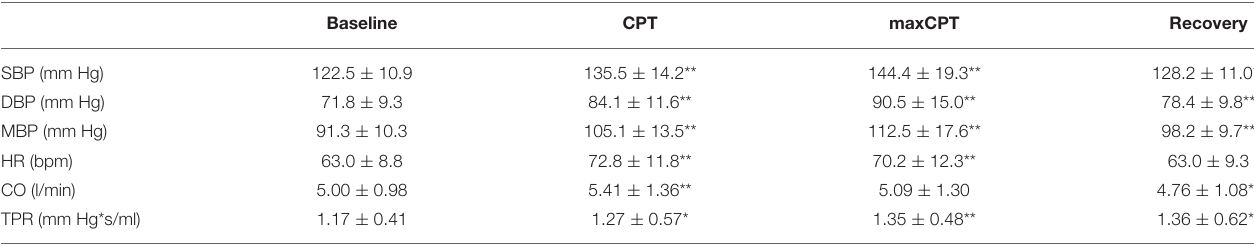
TABLE 1 | Systemic hemodynamic during baseline, CPT, maximal CPT (last 30s of CPT) and recovery (last 60s). Baseline